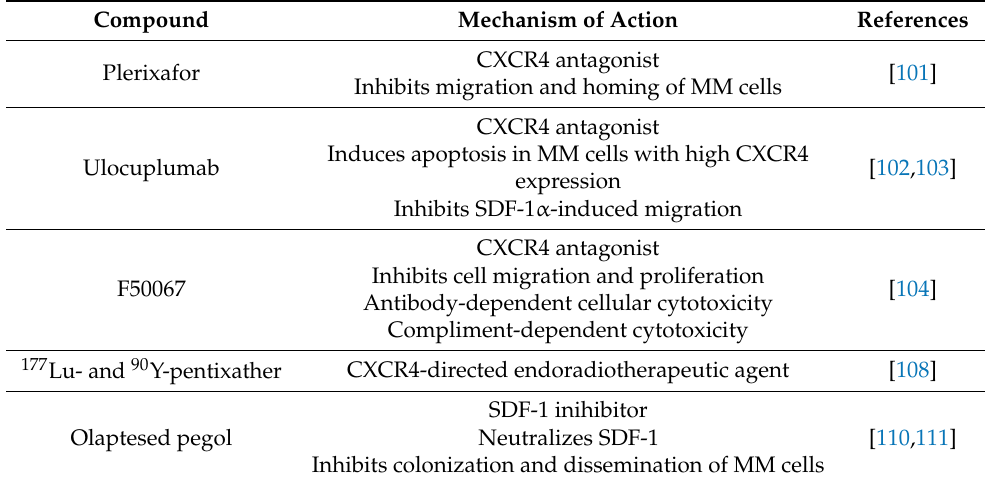
Table 1. Overview of some compounds targeting SDF-1 α /CXCR4 axis in MM